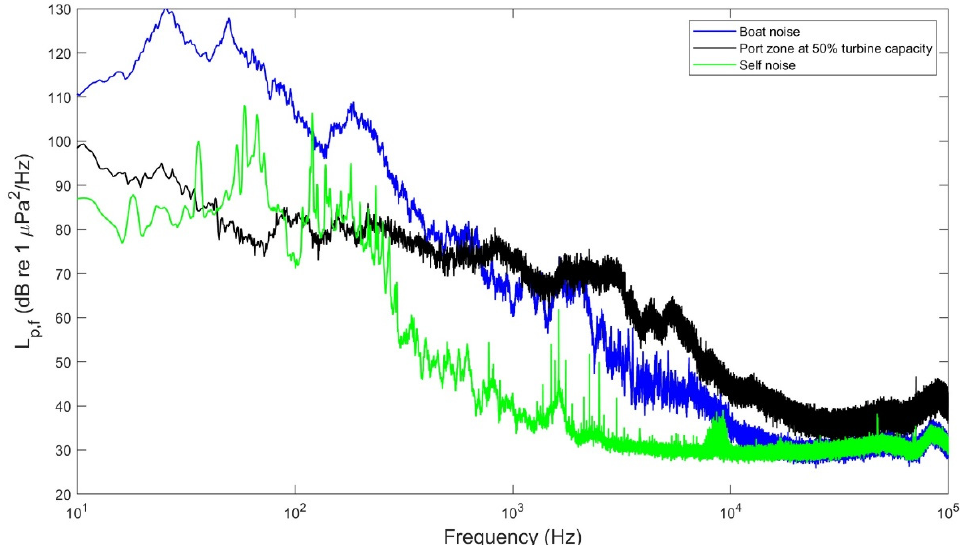
Figure 4. Mean-square sound pressure spectral density levels for a boat (blue) and the 50% rated turbine capacity (black) from the UNH-LB drifting hydrophone recordings. Levels from a reference self-noise recording by the system from the laboratory bench are also shown (green).